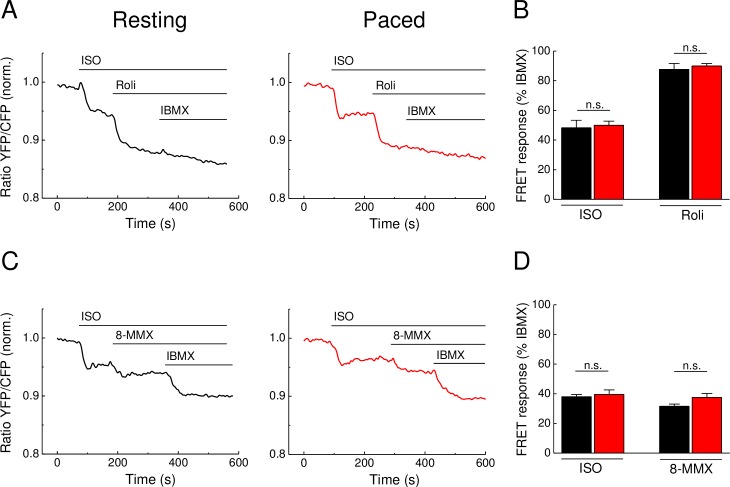
Subsarcolemmal cAMP dynamics in adult mouse ventricular cardiomyocytes transgenically expressing pmEpac1 biosensor.(A) Representative FRET traces from pmEpac1 cardiomyocytes stimulated with the β-AR agonist isoproterenol (ISO, 100 nM) and subsequently by the PDE4 inhibitor rolipram (Roli, 10 μM) followed by the unselective PDE inhibitor IBMX (100 μM) as described in Fig 1C and 1D. (C) Representative FRET traces from pmEpac1 cardiomyocytes stimulated with ISO (100 nM) and subsequently by the PDE1 inhibitor 8-MMX (30 μM) followed by the unselective PDE inhibitor IBMX (100 μM) as described in Fig 3A and 3B. (B and D) Quantification of the FRET results reveal no significant differences in FRET ratio changes between resting and paced cardiomyocytes treated with ISO, rolipram or 8-MMX. Cells were paced at 1 Hz. Values are means ± SEM; from n = 12 and n = 11 cells (unpaced and paced, respectively) isolated from 3 hearts per condition in B and n = 9 cell from 2 hearts each in D; n.s.—not significant by one-way ANOVA.